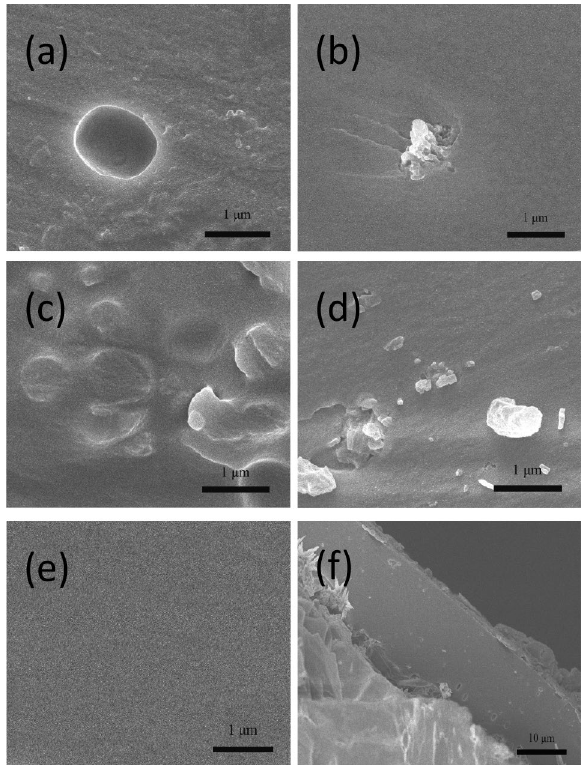
Figure 6. SEM images of cross-section morphologies of coatings. PU/1 wt% POSS-PEG nanocomposite (PCU/ PEG1) ( a ), PU/1 wt% POSS-BEN nanocomposite (PCU/BEN1) ( b ), PU/2 wt% POSS-PEG